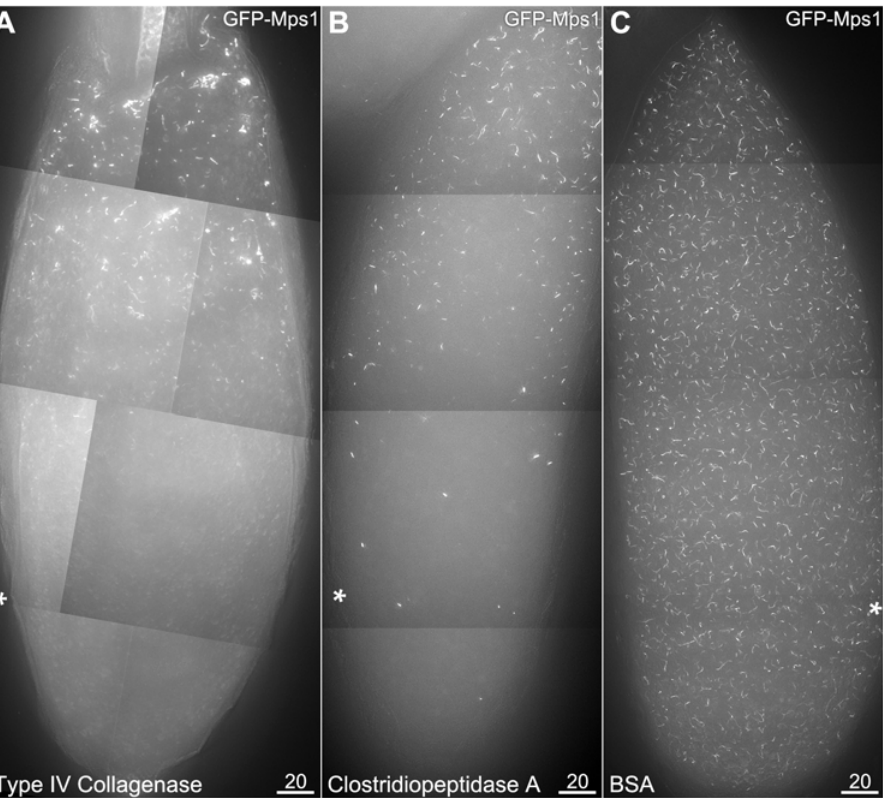
Figure 4. Injected collagenase enzyme disrupts localization to filaments. Oocytes are positioned with their anterior ends at the top, and injection sites are indicated by asterisks. As the oocyte is too large to be imaged in its entirety at this magnification, images are composites of multiple image stacks, acquired and combined using the Panels and Stitch functions in SoftWoRx. GFP-Mps1 is shown; GFP-Polo responded similarly (data not shown). 4A: Injection of a crude collagenase (Type IV, Gibco) prevented the localization of GFP-Mps1 to filaments in the region around the injection site under hypoxia. 4B: Injection of high purity Clostridiopeptidase A enzyme (Sigma-Aldrich) also prevented the localization of GFP-Mps1 to filaments after exposure to CO 2 in the region surrounding the injection site (asterisk). 4C: Control injection of water (data not shown) or a protein solution (5 mg/ml BSA) did not disrupt localization of GFP-Mps1 to the filaments.